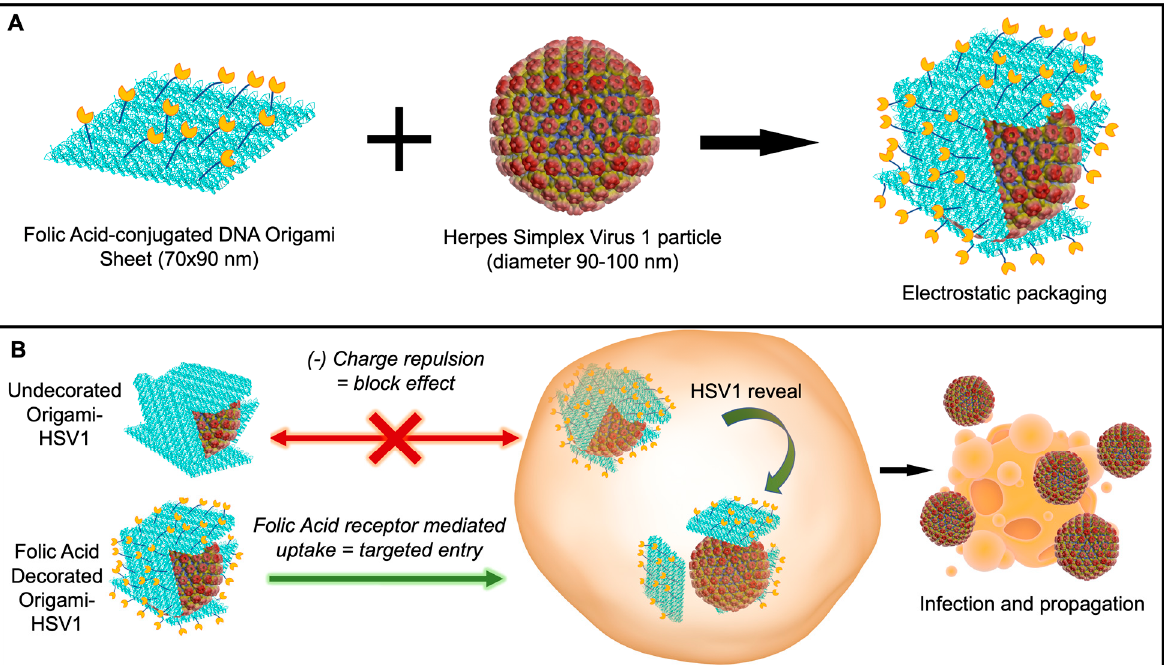
Figure 1. Schematic of Disguised HSV1 through DNA Origami. ( A ) Wrapping HSV1 in folic acid (yellow)-adorned DNA origami (blue). ( B ) In vitro delivery experiments on the (1) disguise of HSV1 and (2) targeted initial uptake into folate-receptor positive cell surfaces.